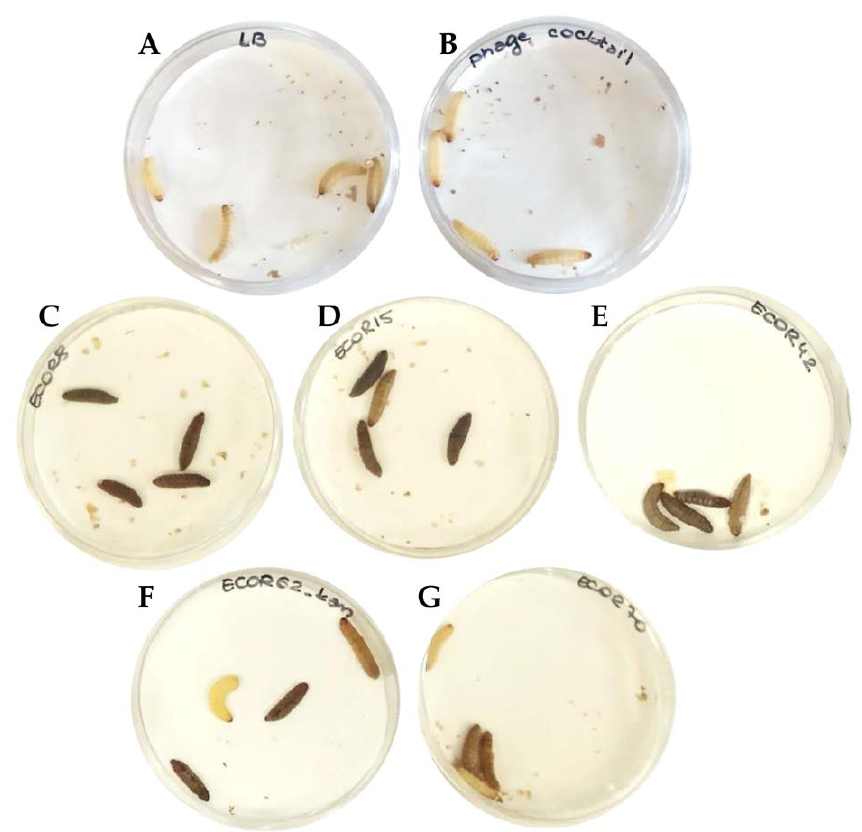
Figure 4. Evaluation of the impact of ECOR strains on Galleria mellonella melanization and/or survival. Controls of the background medium LB ( A ) and the phage cocktail ( B ) were evaluated. Larvae were injected with suspensions containing approximately 10 5 cells of individual ECOR strains, namely ECOR8 ( C ), ECOR15 ( D ), ECOR42 ( E ), ECOR62 ( F ), and ECOR70 ( G ). The degree of melanization was recorded after 16 h incubation at 37 °C.